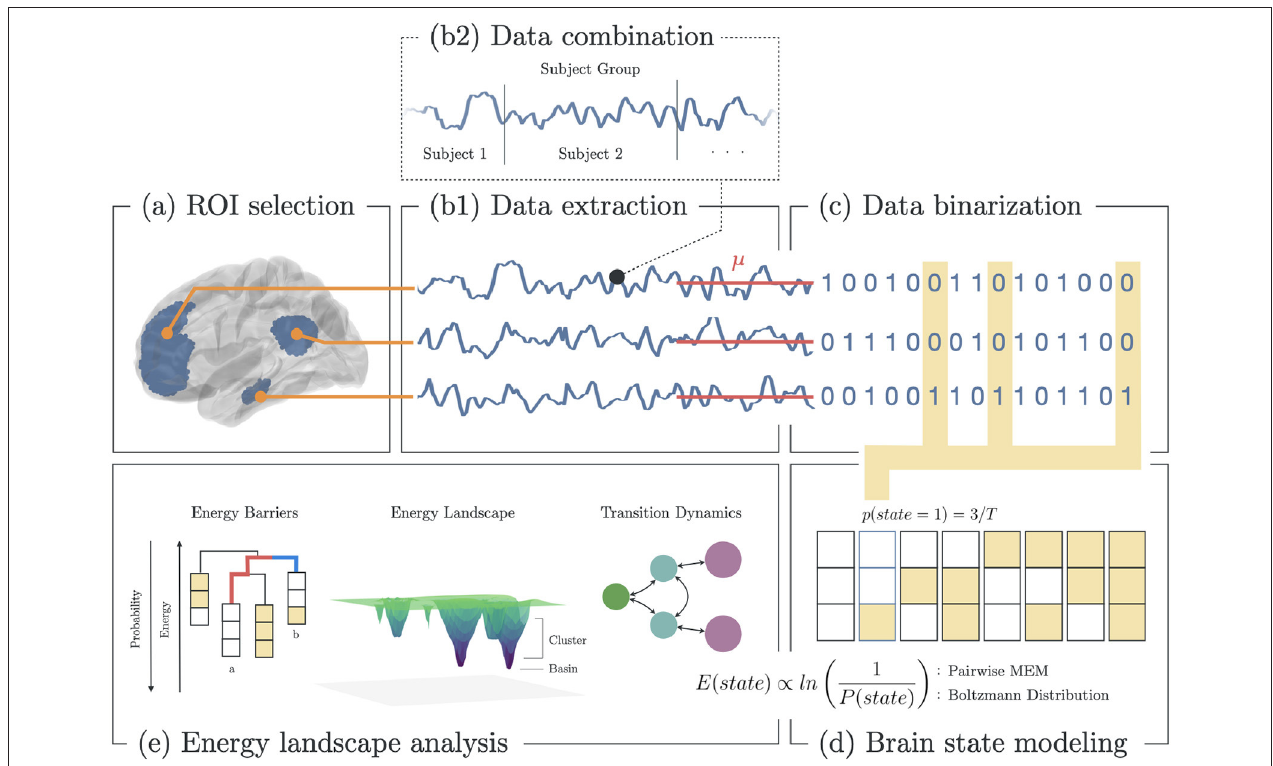
FIGURE 1 | Methodology for energy landscape analysis. (a) Selection of ROI based on functional brain networks associated with depression. (b1) Extraction of fMRI BOLD signals from each ROI. (b2) All signals from subjects within group (healthy, melancholic, non-melancholic) are combined. (c) Binarization of each signal using the mean BOLD value for each ROI. (d) Estimation of the state energy based on the emprical state frequency/probability. (e) Energy landscape analysis, which includes analyses of state energy levels, basin state landscape, and state transition dynamics. Note that as the energy of a state increases, its probability of occurrence